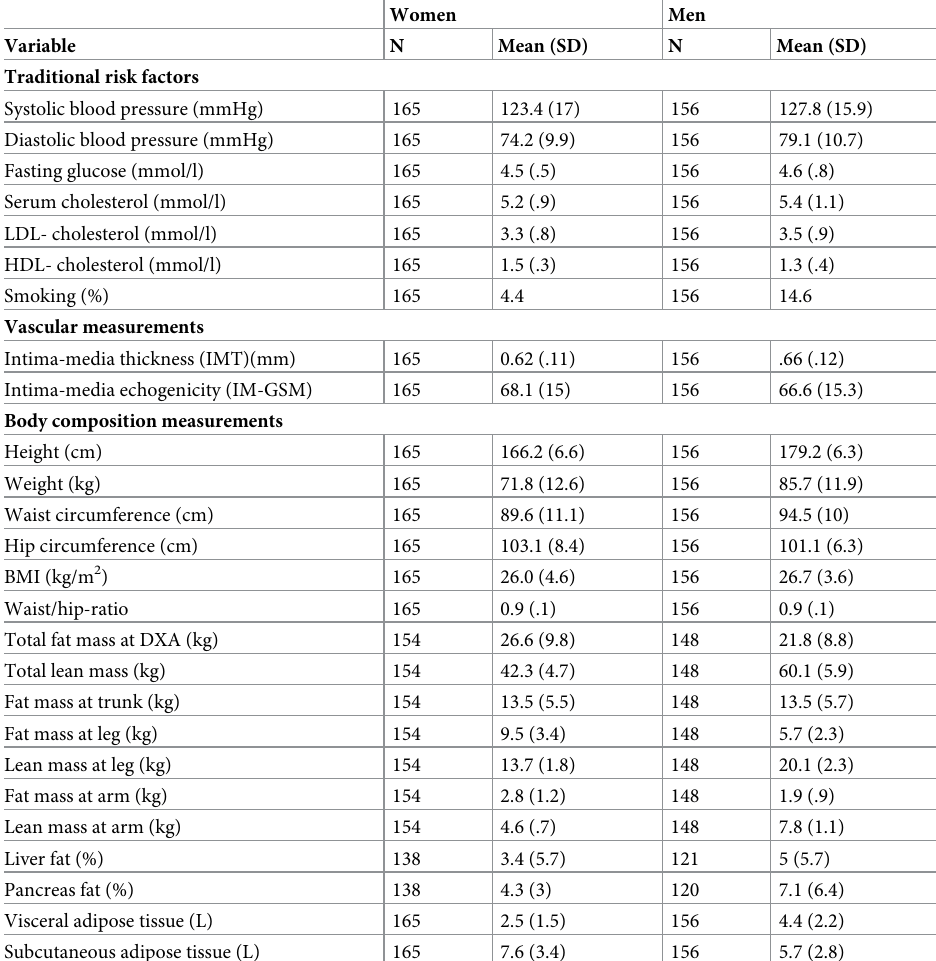
Table 1. Basic characteristics of the